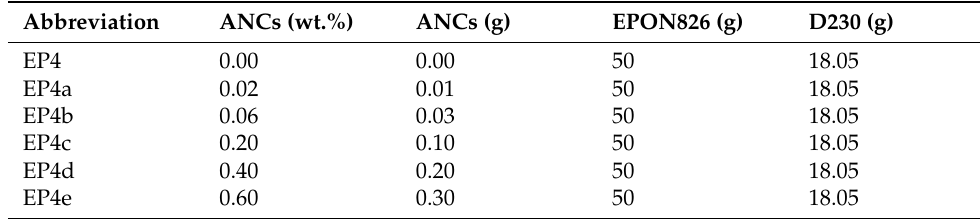
Table 2. Detailed composition of prepared